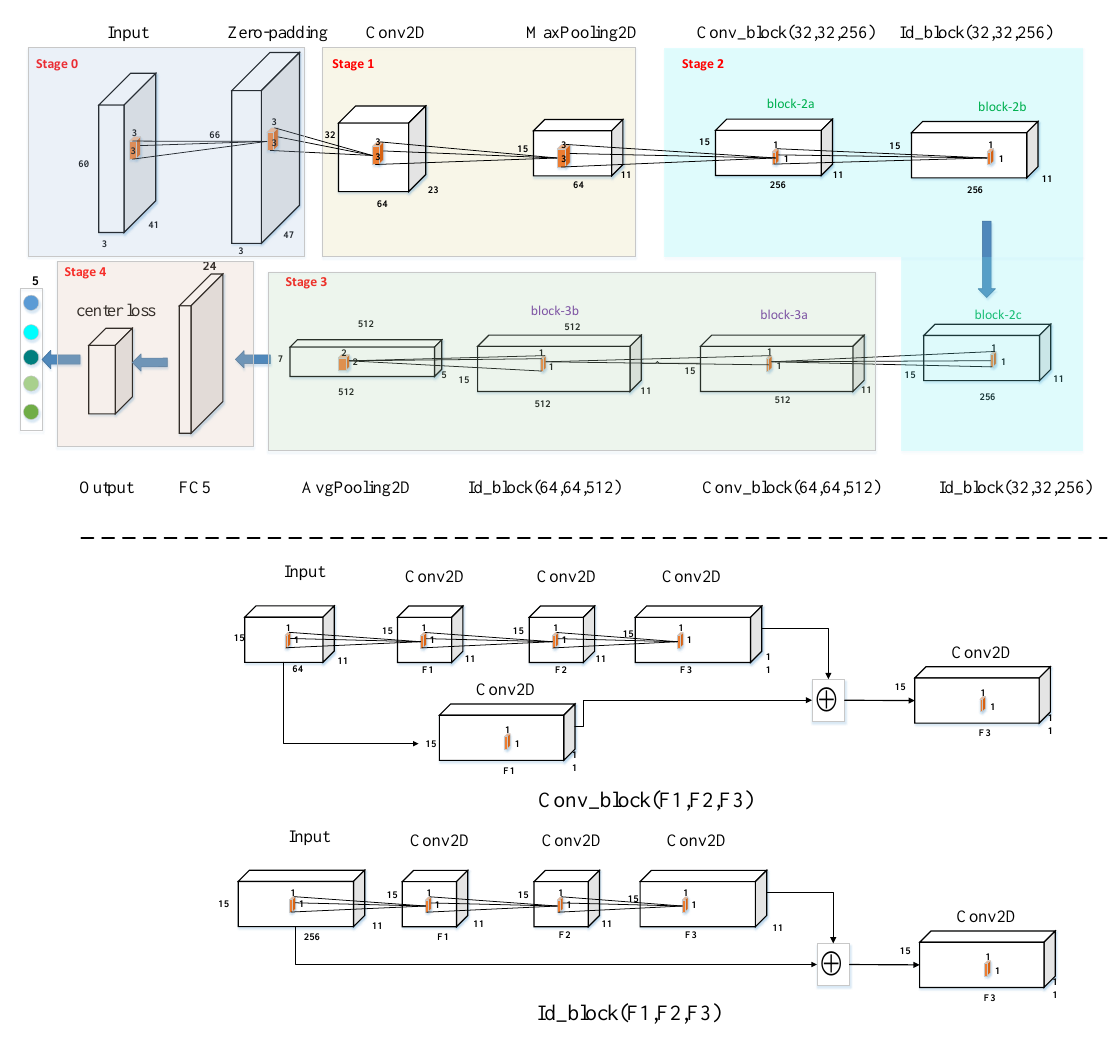
Figure 4. The overall framework of an 18-layer Residual Network (ResNet18).